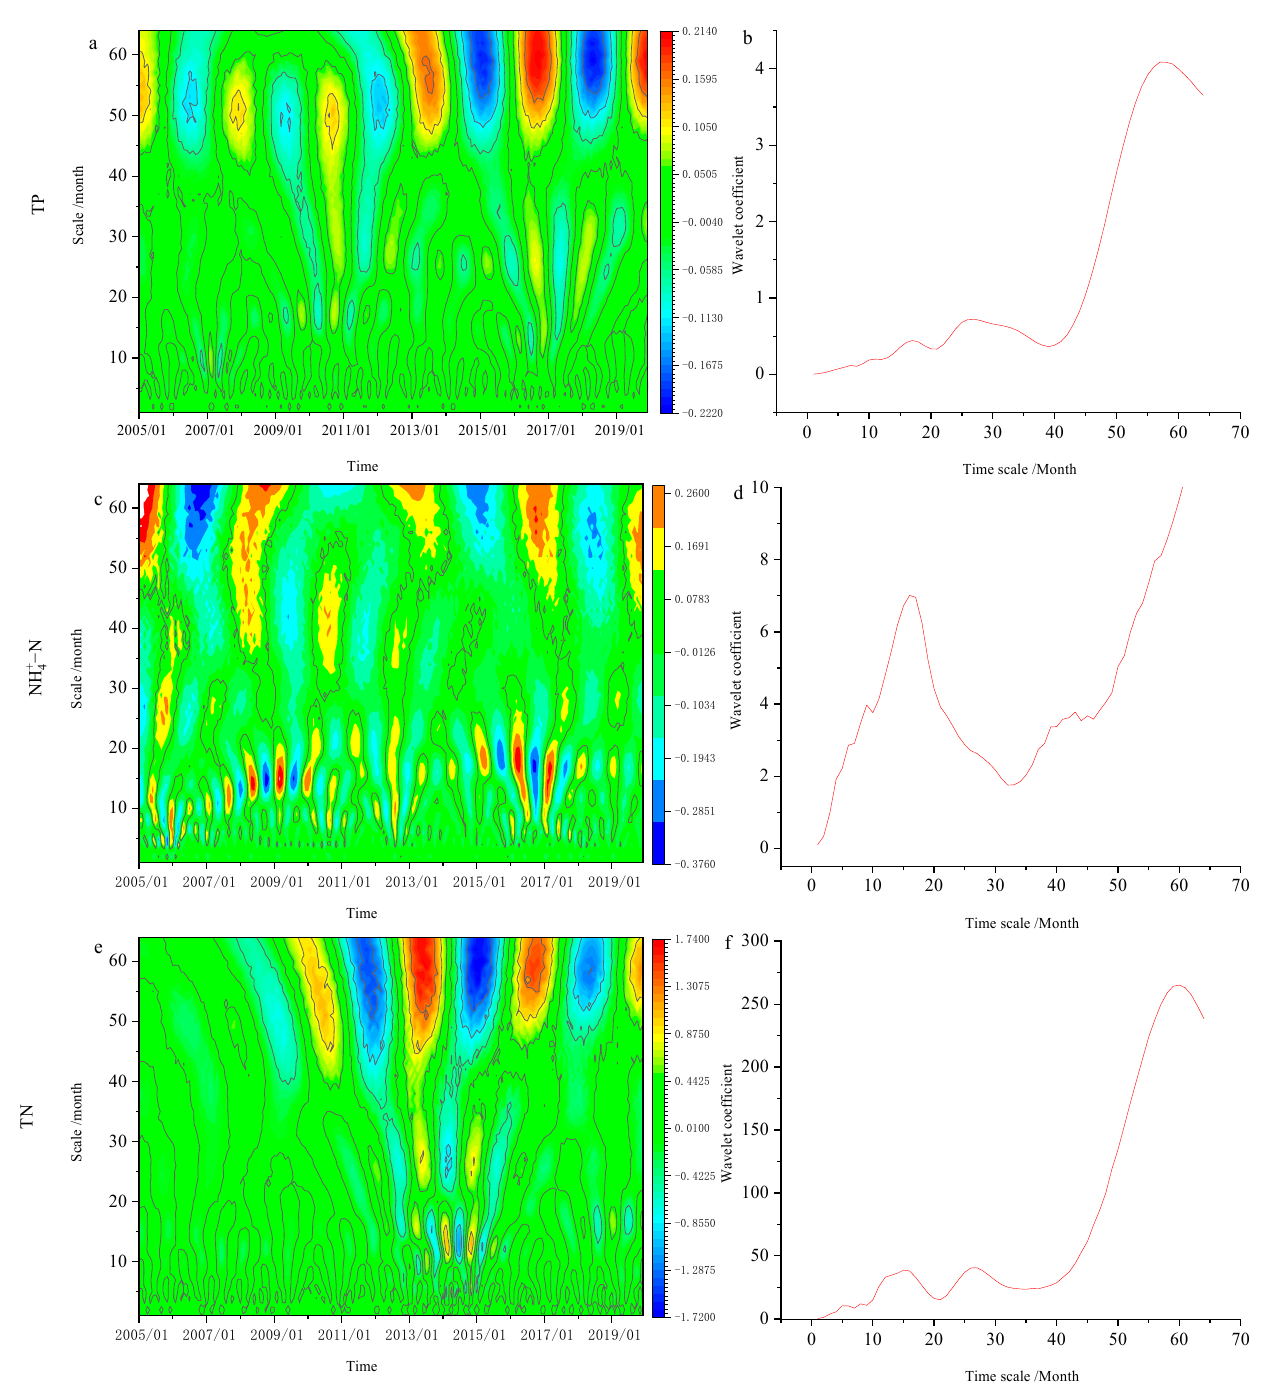
Figure 5. Real part isoline of wavelet coefficients and wavelet coefficient variance of nutrients in the River Yi. ( a , c , e ) are real part isoline of TP, NH + –N, TN. NH + –N, 4